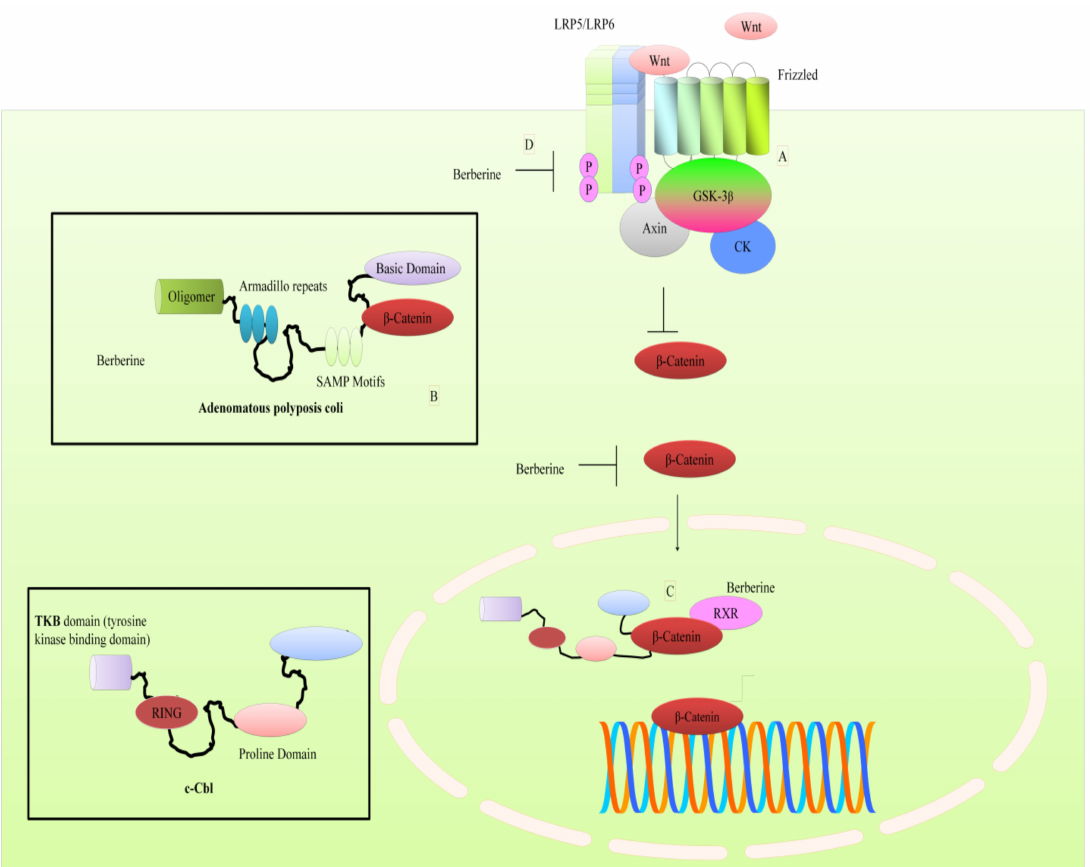
Figure 1. ( A ) WNT / β -catenin mediated intracellular signaling. β -catenin moved into the nucleus to stimulate expression of target genes. ( B ) Berberine promoted interaction of β -catenin and APC to enhance degradation of β -catenin. ( C ) Berberine also promoted interaction of β -catenin with c-Cbl in nucleus that also induced degradation of β -catenin. ( D ) Berberine inhibited phosphorylation of LRP5 / 6 and GSK-3 β . Abbreviations: c-Cbl (CASITAS B-lineage lymphoma protooncogene), LRP5 / 6 (Low density lipoprotein receptor-related protein), CK (Casein Kinase), GSK-3 β (Glycogen synthase kinase), RXR (Retinoid X-receptor), WNT (Wingless / Integrase), SAMP (Ser-Ala-Met-Pro motif), RING (Really interesting new